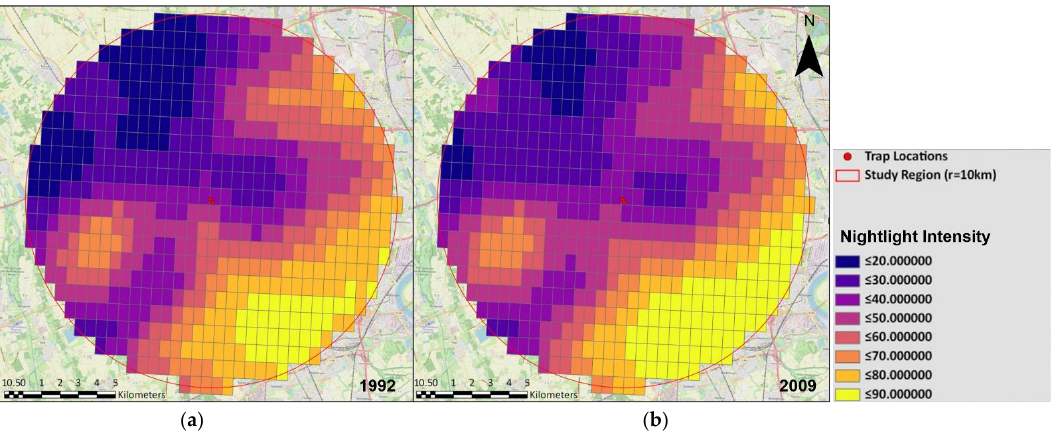
Figure 3. Example of intercalibrated DMSP-OLS intensity data over the study area in the first ( a , 1992) and second to last ( b , 2009) years of the time series. The southeast portion of the study area (highlighted most in b ) corresponds to the highest density urban areas.